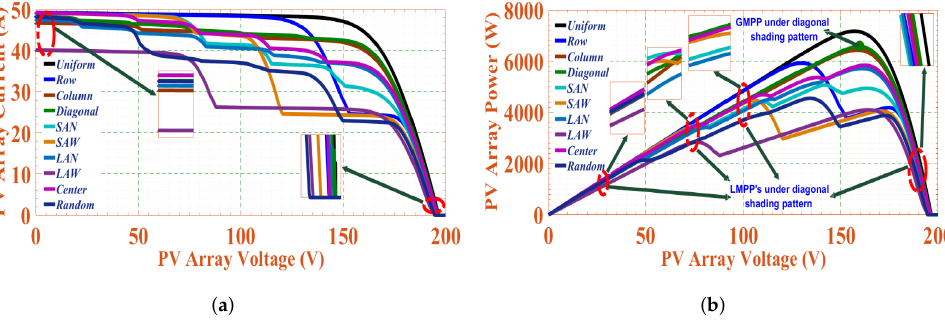
Figure 6. Results of B-L topology under various PSCs. ( a ) I-V characteristics, and ( b ) P-V characteristics.